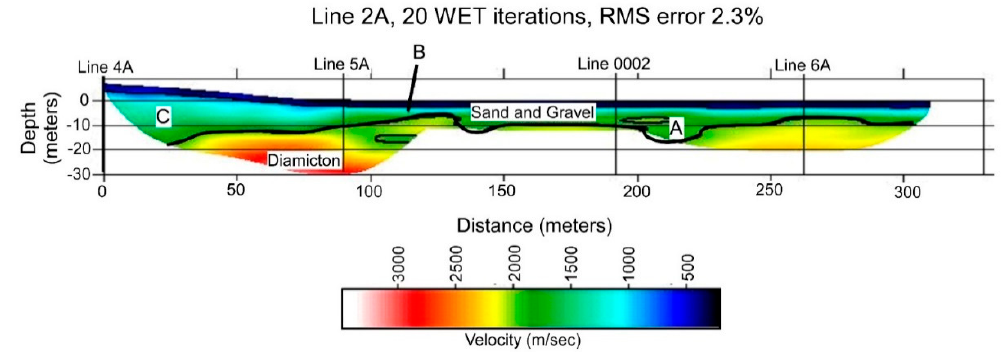
Figure 10. North-South velocity profile of Line 2A. South is to the left. Areas A and C are channels, and area B represents a paleotopographic high such as a terrace or is velocity anomaly.